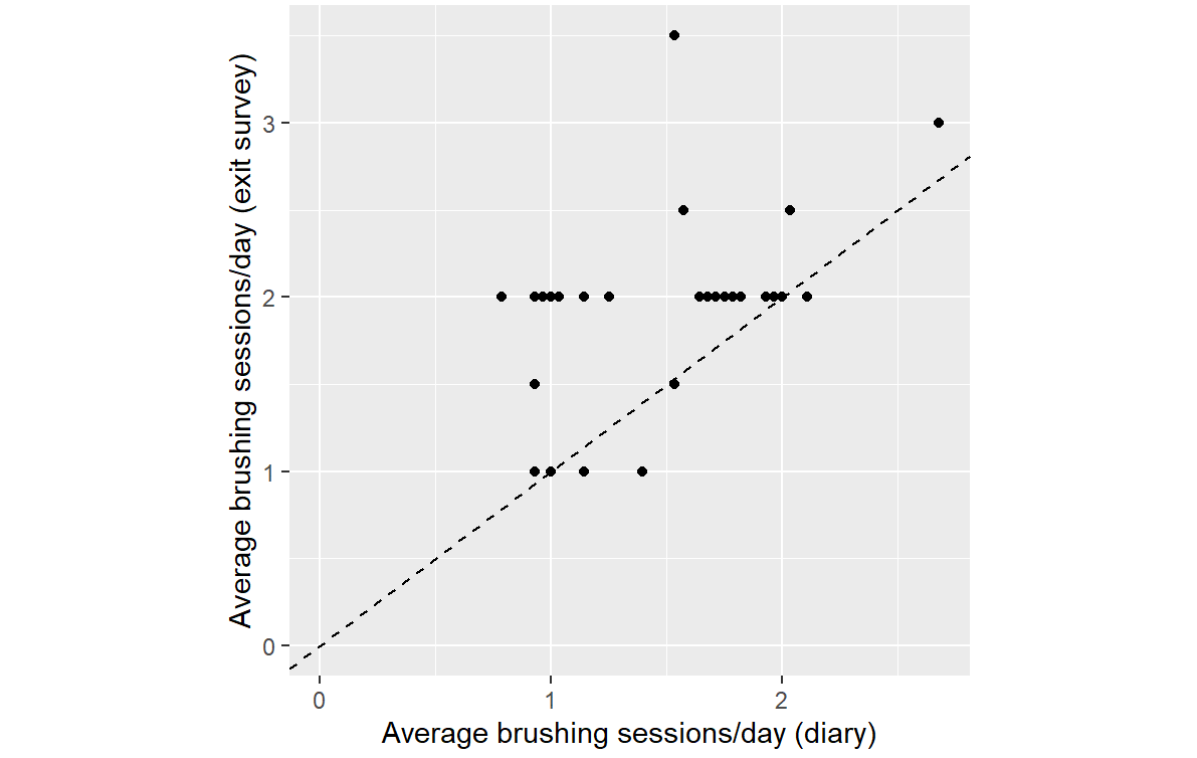
Figure 5. Mean daily brushing sessions, as measured by brushing diaries versus retrospective